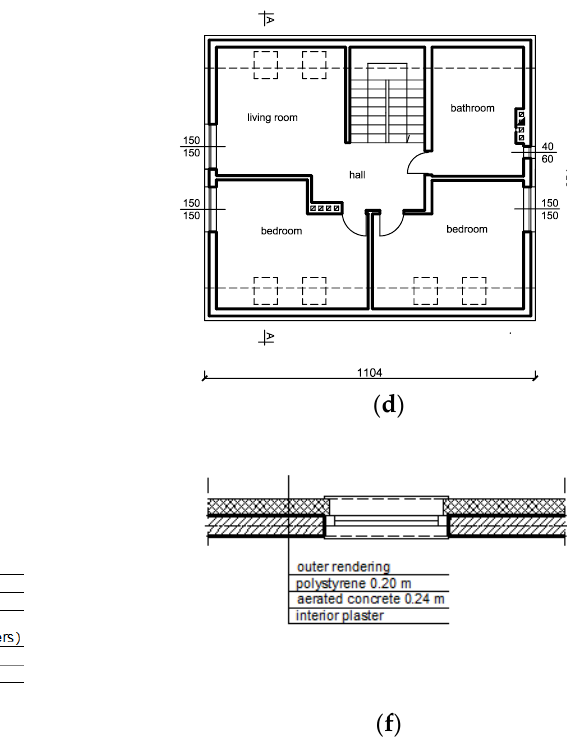
Figure 1. Schematic drawings of the single-family building under examination: ( a ) front elevation; ( b ) vertical section; ( c ) ground floor plan; ( d ) plan of the usable attic; ( e ) connection of the wall with the floor slab and the wall with the roof; ( f ) installation the window in wall (own elaboration).